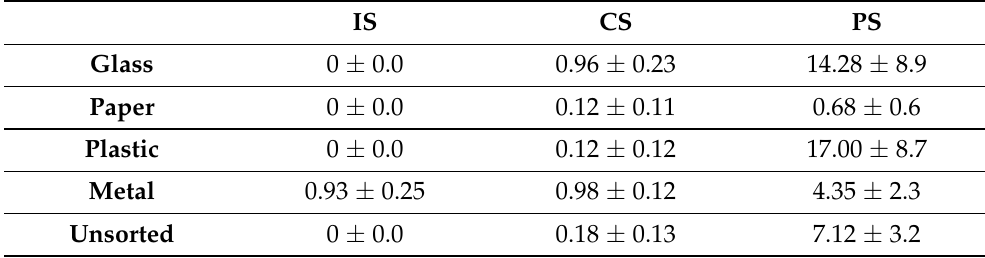
Figure 8. A sample of the pictures used as training dataset. The objects were acquired by the waste sensing module directly on the white shelf of the waste disposal unit. Table 2. Summary table reporting the per class average and standard deviation obtained by the Inductive Sensor (IS), Capacitive Sensor (CS) and Photoelectric sensors